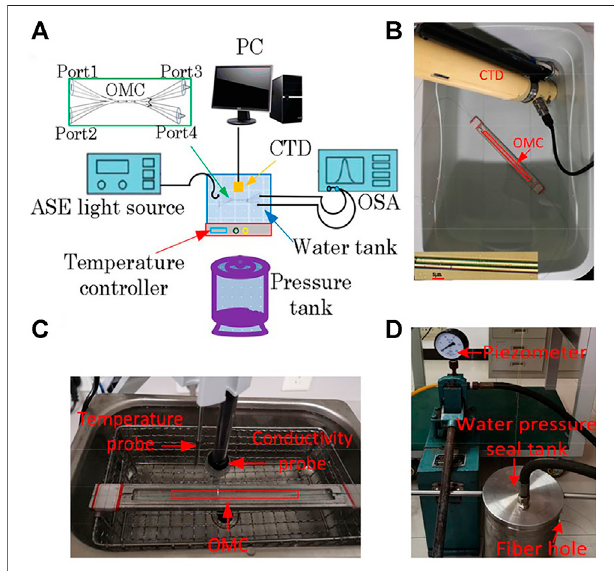
SCHEME | (A) Schematic of the experiment setup for the measurement of salinity, temperature and depth in seawater. (B) The salinity measuring experimental setup and the optical microscopic image of an OMC sample (Inset). (C) The temperature measuring experimental setup. (D) The depth measuring experimental setup